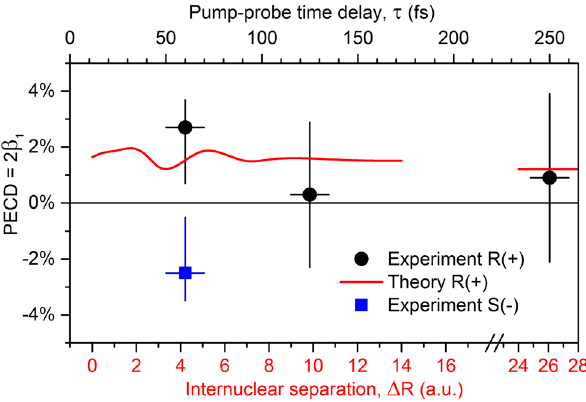
Fig. 3 Comparison of experimental and theoretical results. Average PECD of all combinations of remaining and dissociating fl uorine atoms in singly charged C 3 H 3 F 2 O + in its R-enantiomeric form, measured at different time delays between the pump and probe X-ray pulses (shown by circles with error bars; refers to the upper horizontal scale), together with the corresponding average theoretical PECD (solid curve), computed at different internuclear separations R C − F = R eq + Δ R between the C atom on the CF 2 -group of the mother-fragment and the dissociating F + ion along the respective C – F bond (refers to the lower horizontal scale). The two horizontal scales are adjusted via a classical Coulomb explosion model (see text for details). The theoretical value at the largest shown separations represents an asymptotic PECD for R C − F = ∞ . Experimental PECD measured for S-enantiomer at the delay of 60 fs is shown by solid square with error bars (refers to the upper horizontal